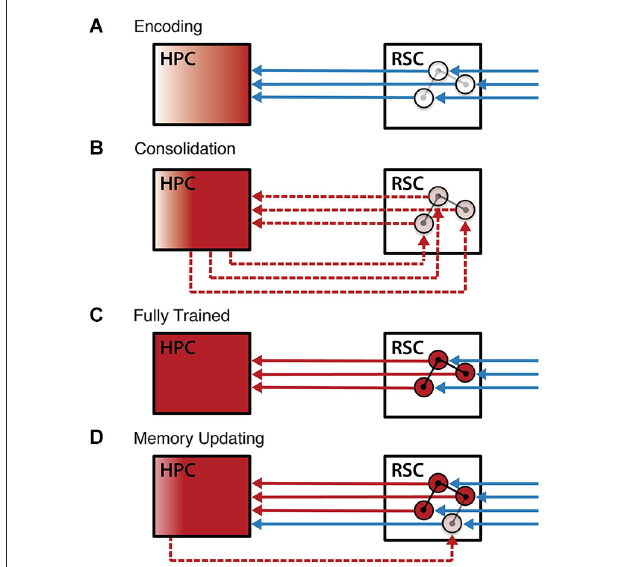
FIGURE 6 | Working model of RSC-hippocampal interaction during learning . A model of RSC-hippocampal interactions over the course of learning. (A) Encoding in naïve animals is characterized by feedforward sensory information (blue lines) driving plasticity in both the cortex and the HPC. Plasticity in the RSC (circles and their connections) includes the early formation of cue-related activity, while plasticity in the HPC leads to the formation of a stable hippocampal memory representation (red). (B) After the learning event, interactions between the RSC and the HPC (dashed red lines) consolidate memories into a more stable form. (C) In the fully trained subject, feedforward sensory input activates the consolidated RSC memory representation, which, in turn, activates the corresponding representation in the HPC. (D) Coordinated activity in the RSC and HPC enables memory updating, whereby the detection of novelty by the HPC initiates rapid consolidation of this new information into the existing cortical memory trace. Abbreviations: retrosplenial cortex (RSC), hippocampus